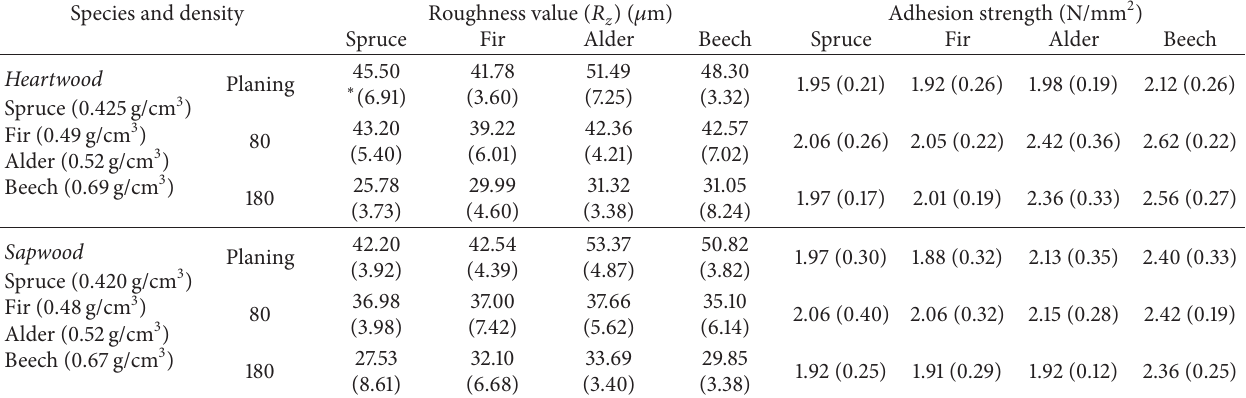
Table 1: Roughness and adhesions strength test